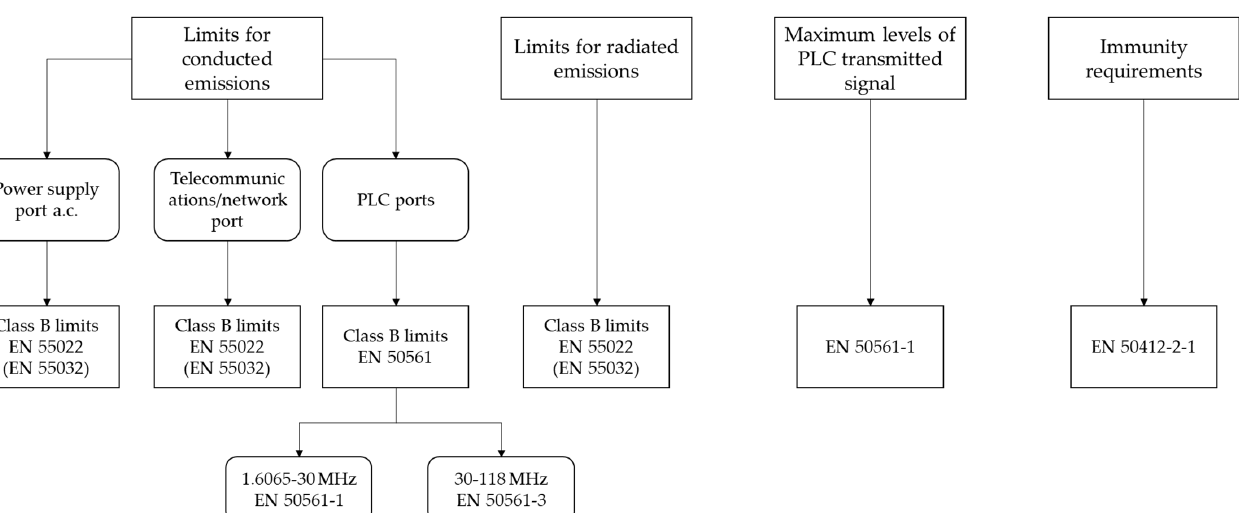
Figure 2. Limits for conducted and radiated emissions, PLC transmitted signal maximum levels, and immunity requirements.